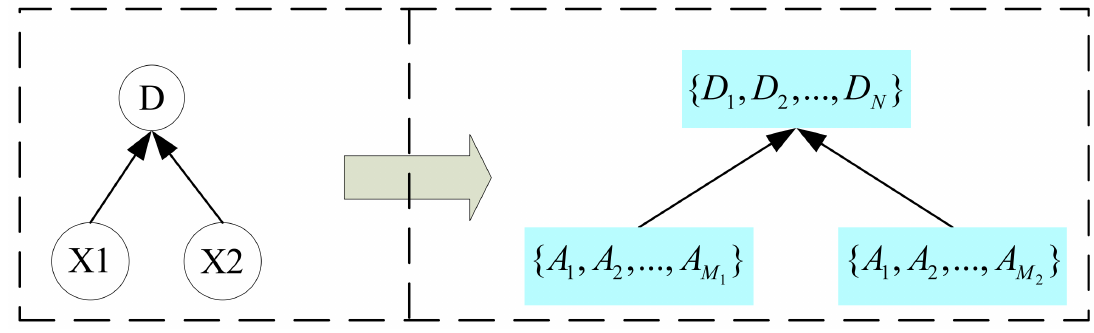
Figure 4. Node representation of Bayesian networks.